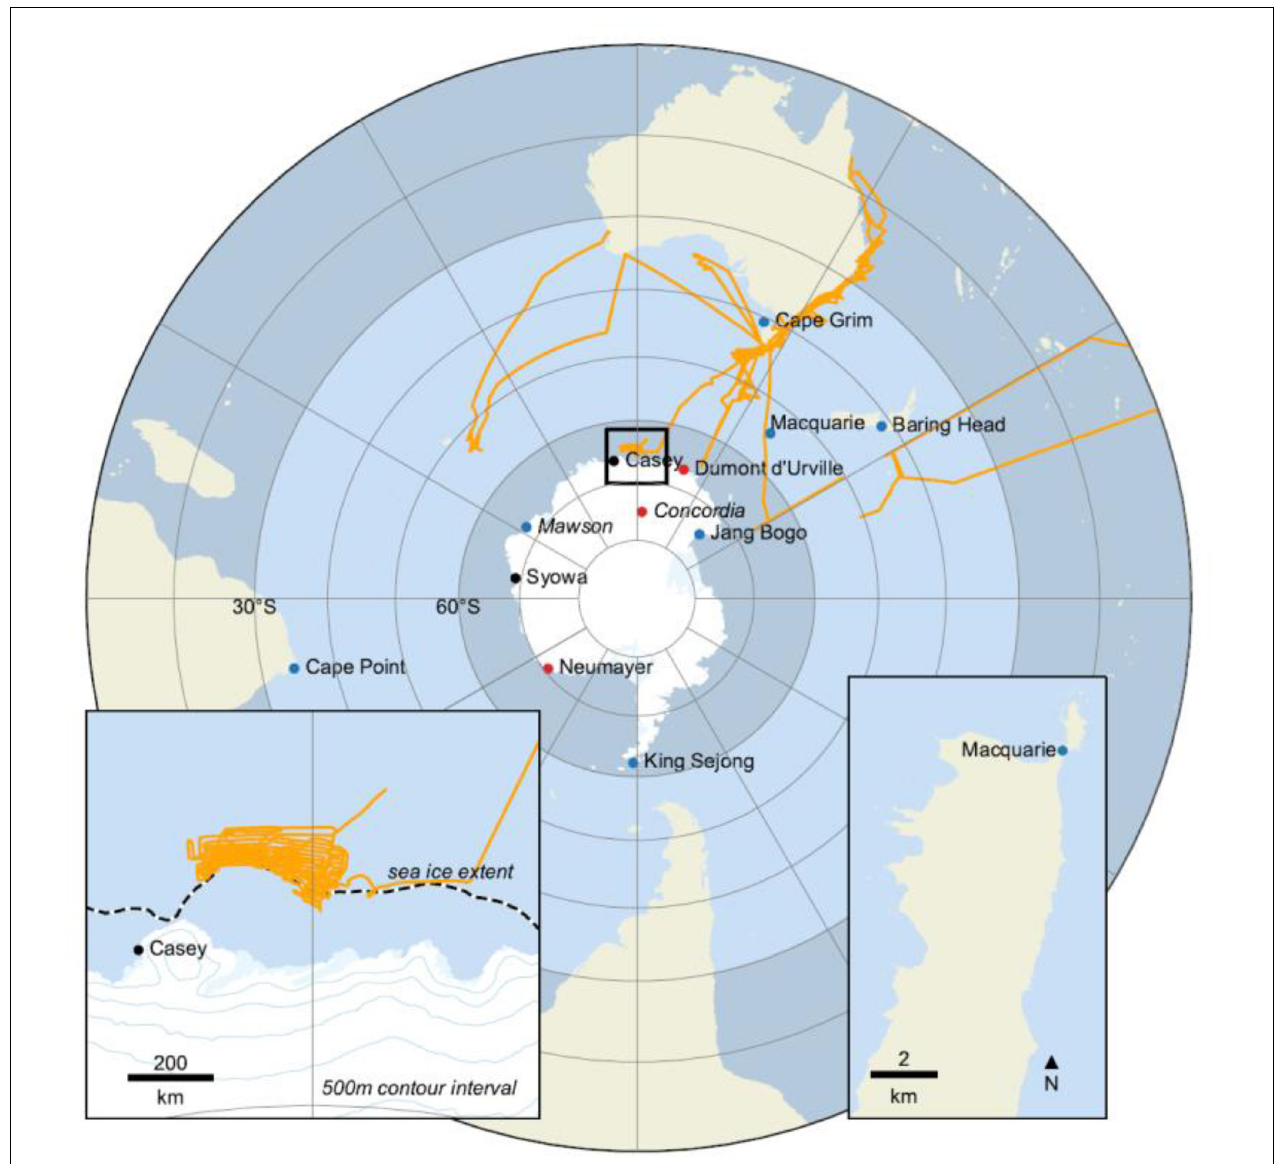
FIGURE 1 | Southern Ocean radon detector network: two-filter detectors (blue), single-filter detectors (red). RV Investigator cruise track (January 2015 to June 2017) shown in orange. Inset 1 shows RV Investigator maneuvers for sea floor mapping (January–February 2017), and includes the February 2017 sea ice extent based on the 20% concentration contour from passive microwave satellite data (Peng et al., 2013; Meier et al., 2017). Ice sheet elevation contours are from ETOPO1 (Amante and Eakins, 2009). Inset 2 shows location of Macquarie Island monitoring station with coastline data from Natural Earth and, for the Macquarie Island inset, the Australian Antarctic Division